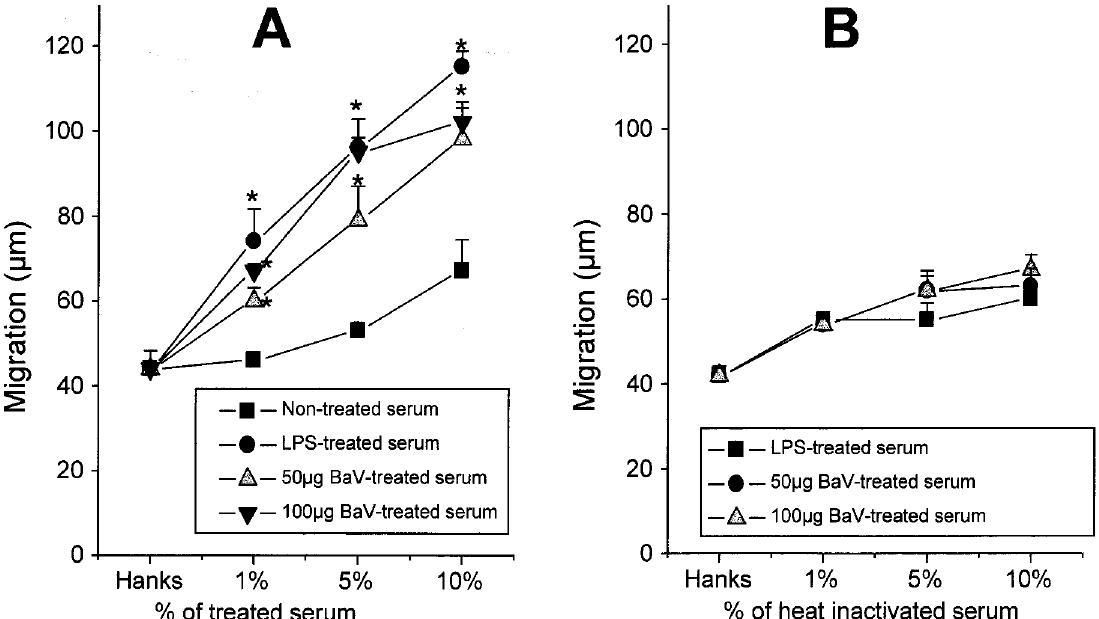
FIG. 2. Chemotactic responses of neutrophils to Bothrops asper venom (BaV) and to lipopolysaccharide (LPS)-treated serum. Neutrophils were placed in the top compartment of the chamber and allowed to migrate for 1h. (A) BaV and LPS were incubated with serum for 30min at 37°C, diluted in Hanks’ balanced solution (HBSS) and used as chemotactic agents. (B) Heating the serum for 1h at 56°C prior to the addition of BaV or LPS prevents its ability to induce neutrophil migration. Values are mean ± standard error of the mean (SEM) of four experiments each performed in duplicate. * p < 0.01 versus values in the group using non-activated